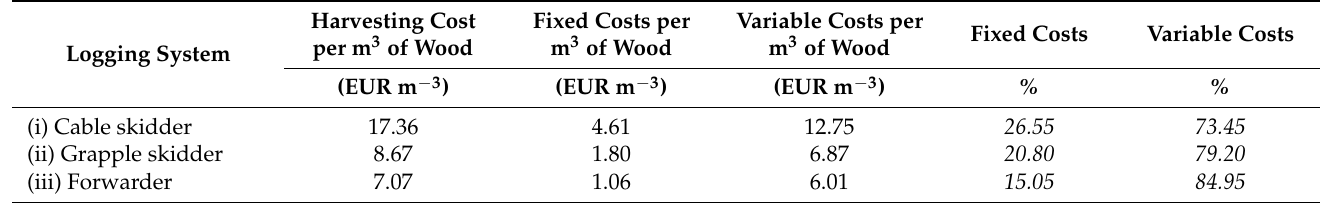
Table 5. Share of fixed and variable costs related to unit costs (EUR m − 3 ) of different logging sce ‐